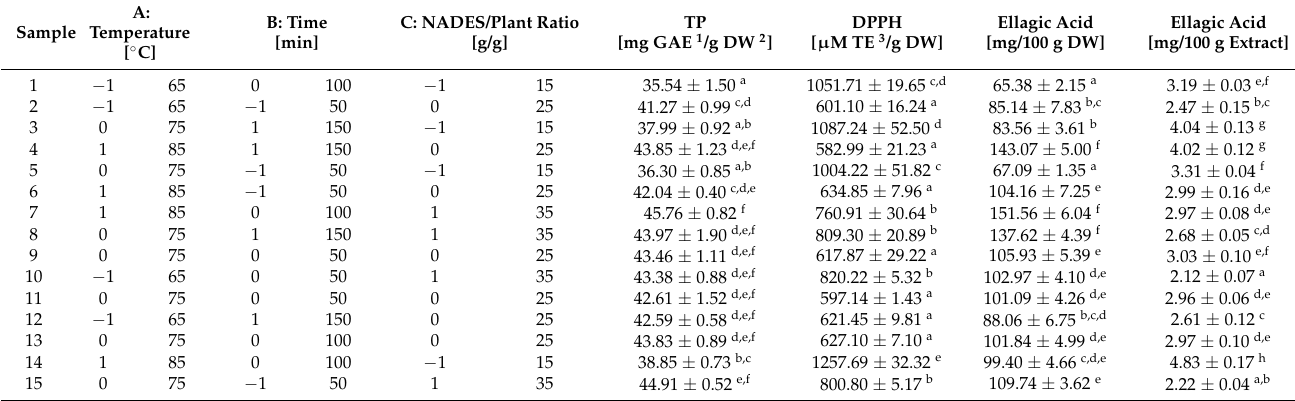
Table 3. Box–Behnken design with process parameters of solid/liquid extraction and experimentally obtained values of total polyphenols (TP) content, antioxidant activity (DPPH), and ellagic acid content expressed on defatted raspberry seeds and NADES